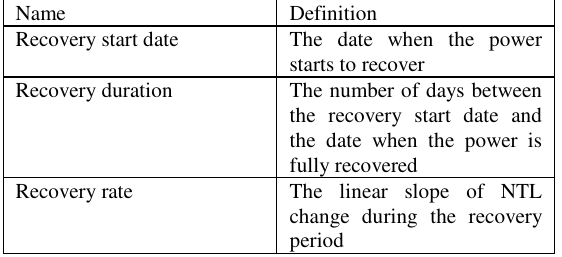
Table 1. Power outage recovery